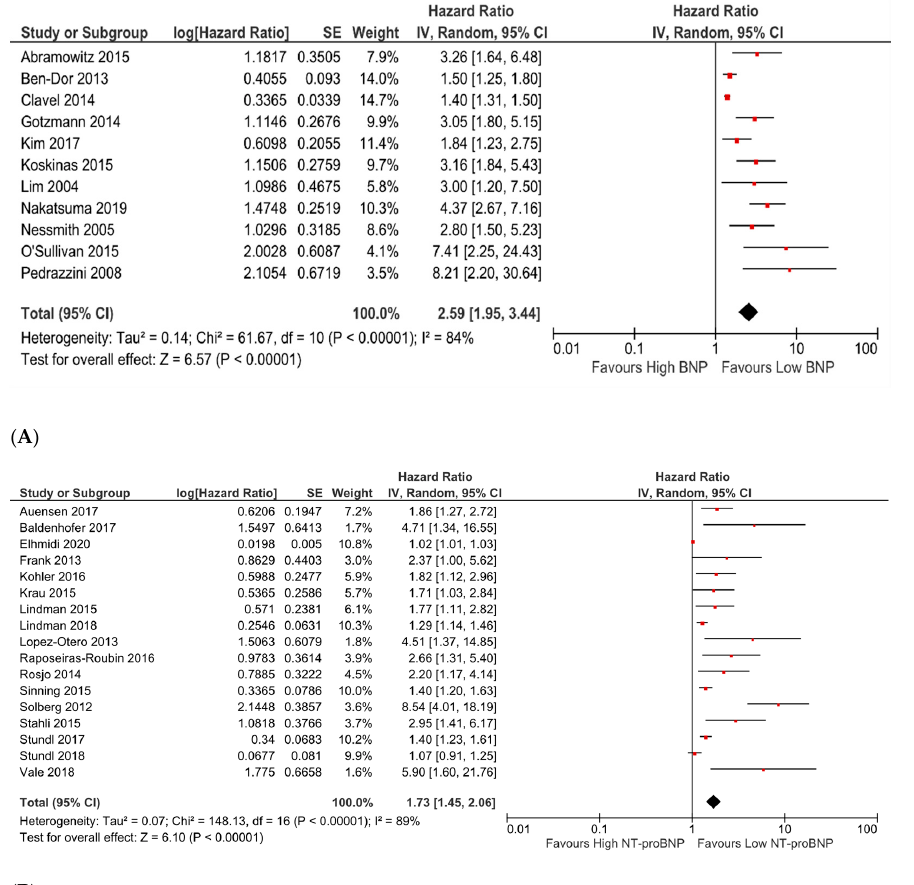
Figure 1. ( A ). Forest plot of hazard and risk ratios of all-cause mortality for high vs. low levels of baseline BNP using a random-effect model. This indicates that when comparing groups of high vs. low BNP as defined by the authors, there was over double the risk of mortality in the higher group. CI: confidence interval; IV: inverse variance. ( B ). Forest plot of hazard and risk ratios of all-cause mortality for high vs. low levels of baseline NT-proBNP using a random-effect model. This indicates that there was 1.73 times the risk of mortality associated with the high-level group. CI: confidence interval; IV: inverse variance.